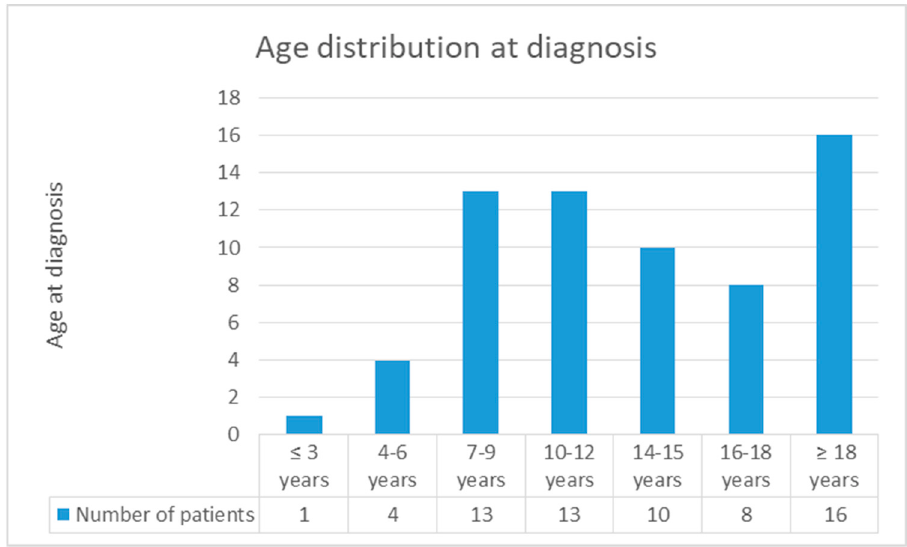
Figure 3. Age distribution at diagnosis.